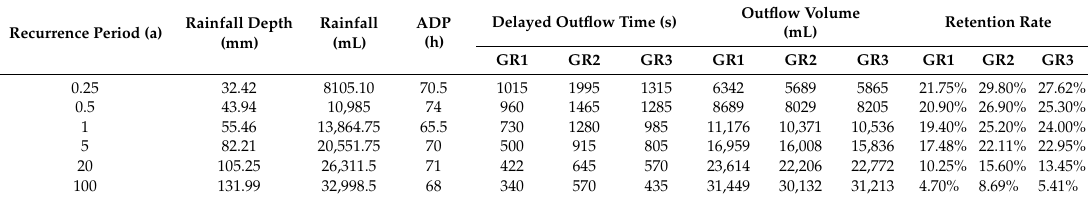
Table 4. Rainfall runo ff retention capacity of the three green roof (GR)